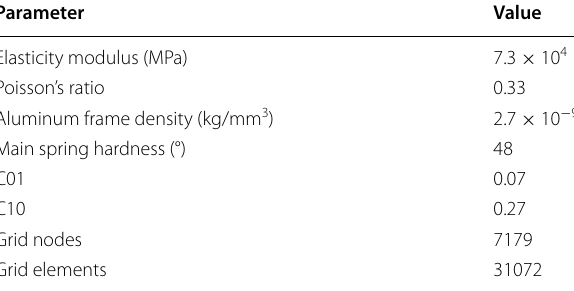
Table 1 Key parameters of finite element